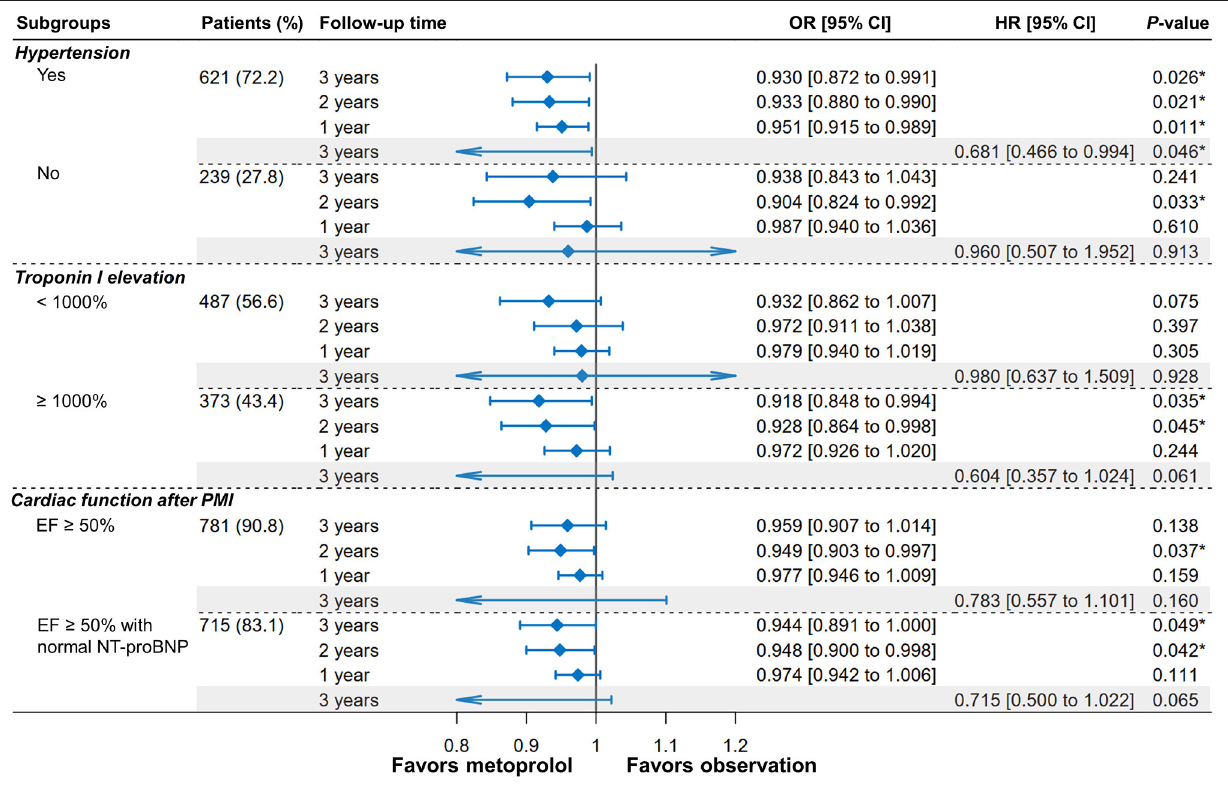
FIGURE 4 | Forest plot of MACEs depicting the IPTW-adjusted odds ratios (ORs) and hazard ratios (HRs) of metoprolol administration vs. observation after PMI according to hypertension, troponin I elevation, and cardiac function. * P <